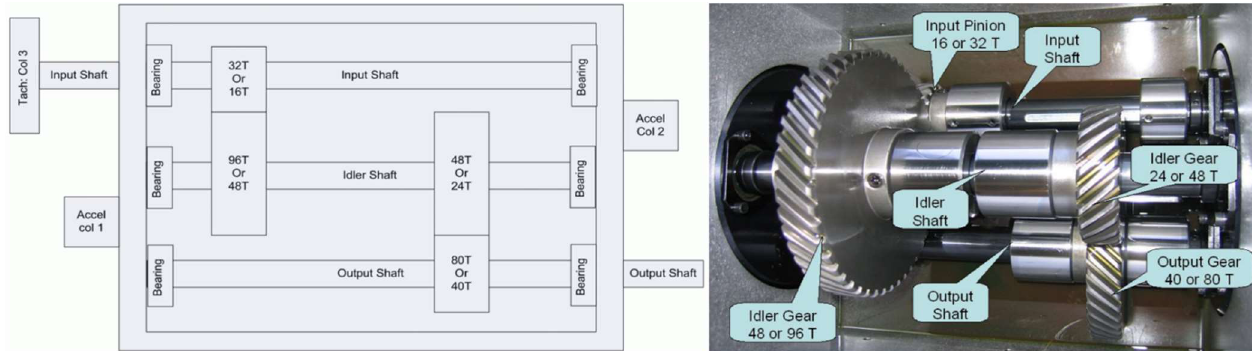
Figure 3. New samples on oversampling algorithms: ( a ) SMOTE, ( b ) LR-SMOTE, ( c ) MeanRadius- SMOTE.